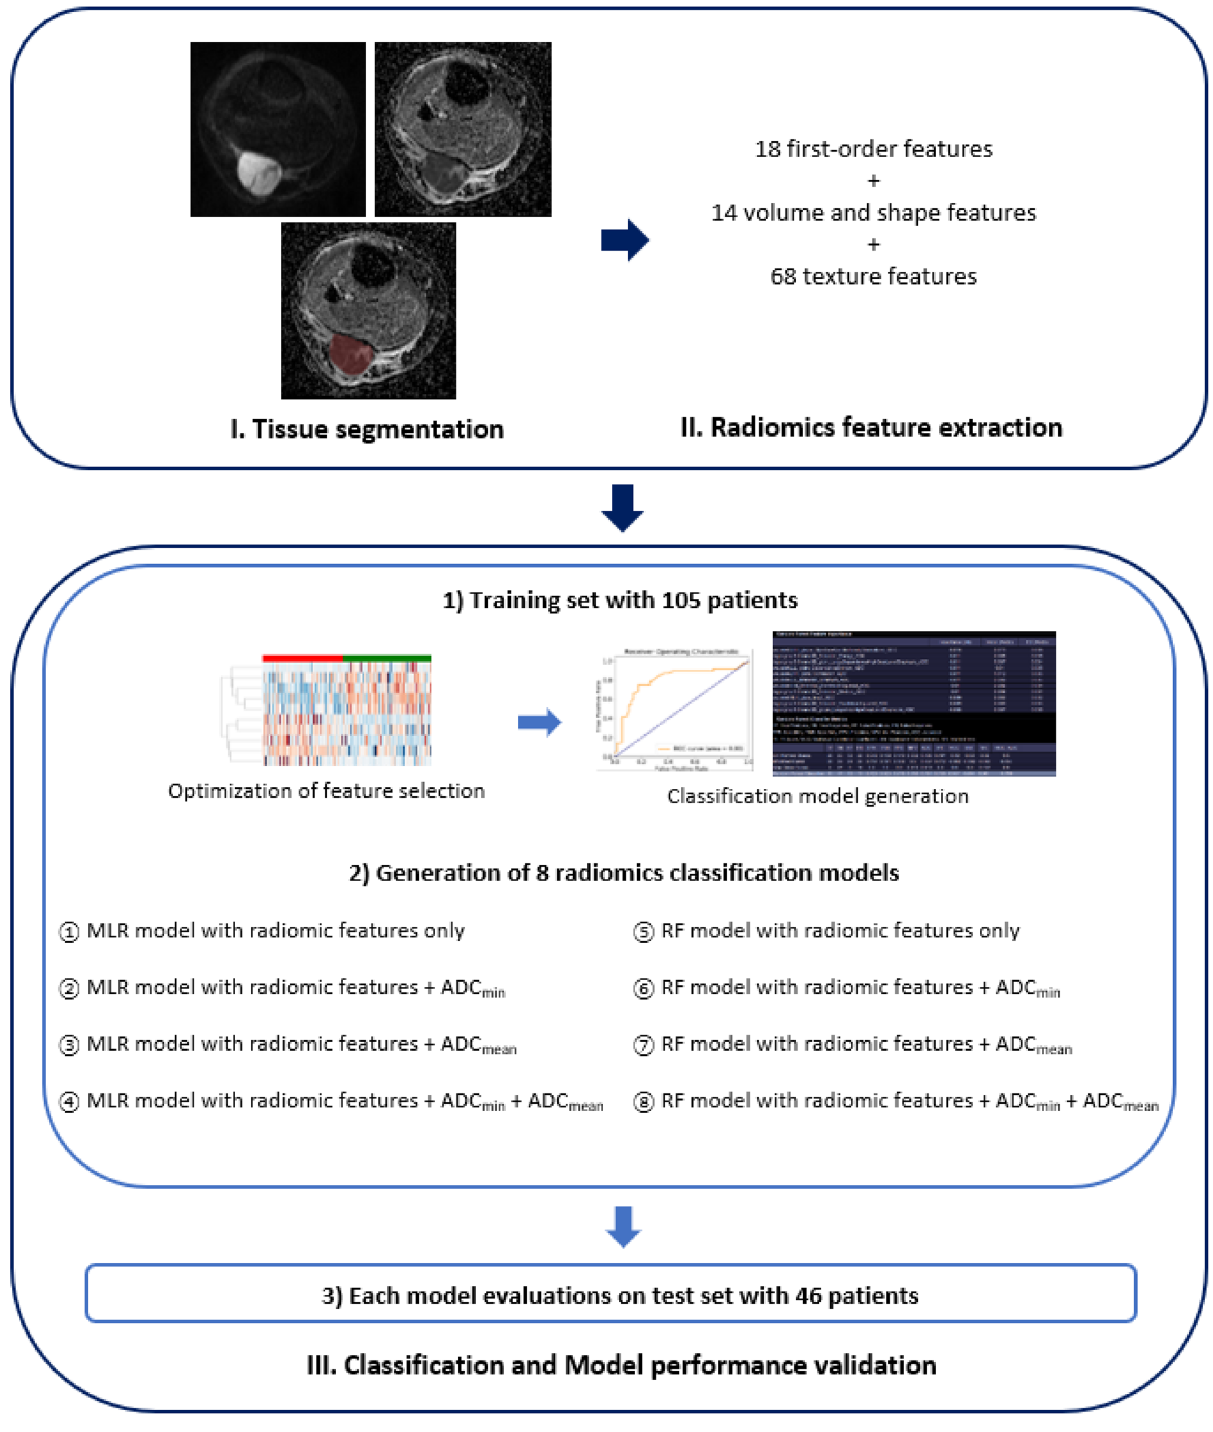
Figure 4. Radiomics pipeline of our study. The diagram was drawn by the first author of the manuscript. The images included in the diagram were captured from the softwares we used : ITK-SNAP software, version 3.8.0 (open source, http:// itksn ap. org/), Syngo. via Frontier Radiomics (Siemens